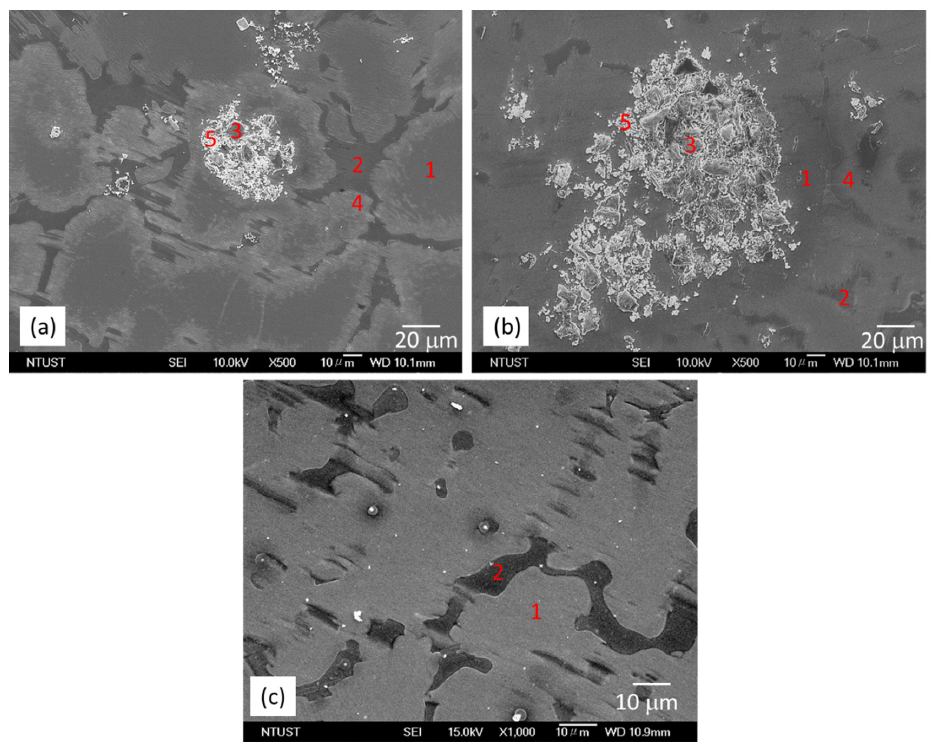
Figure 2. Scanning Electron Microscope (SEM) micrographs showing the selected areas for Energy Dispersive Spectroscopy (EDS) analysis: ( a ) WZ73-1.5 vol% SiC; ( b ) WZ73-2.5 vol% SiC; ( c ) a SEM micrograph of the WZ73 alloy is also shown for comparison. Table 1. Chemical composition of selected areas in the WZ73 alloy and MMCs (at